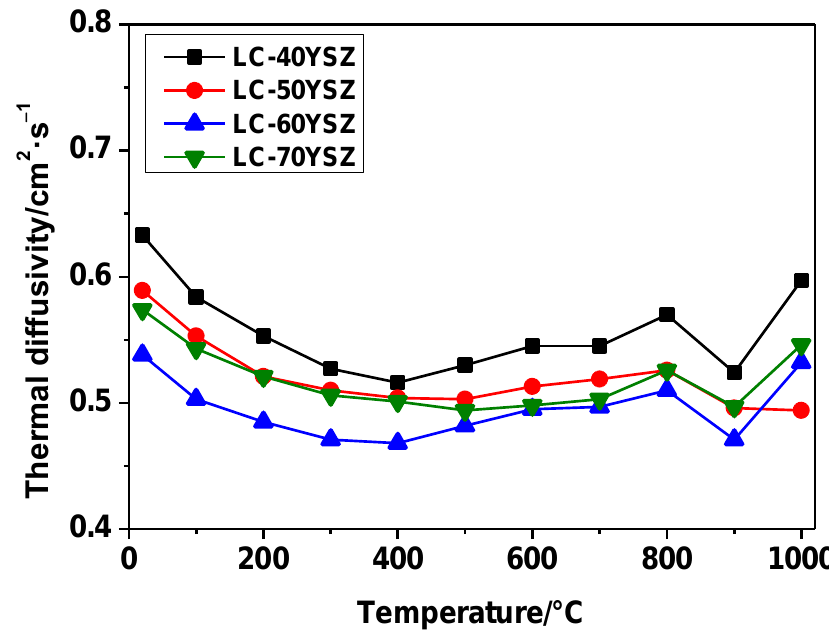
thermal diffusivities increased again, except for the LC-50YSZ bulk. The measured values of thermal diffusivities at 1000 ◦ C were in the range of 0.5–0.6 cm 2 · s − 1 . The observed transport and/or disintegration of the graphite film.